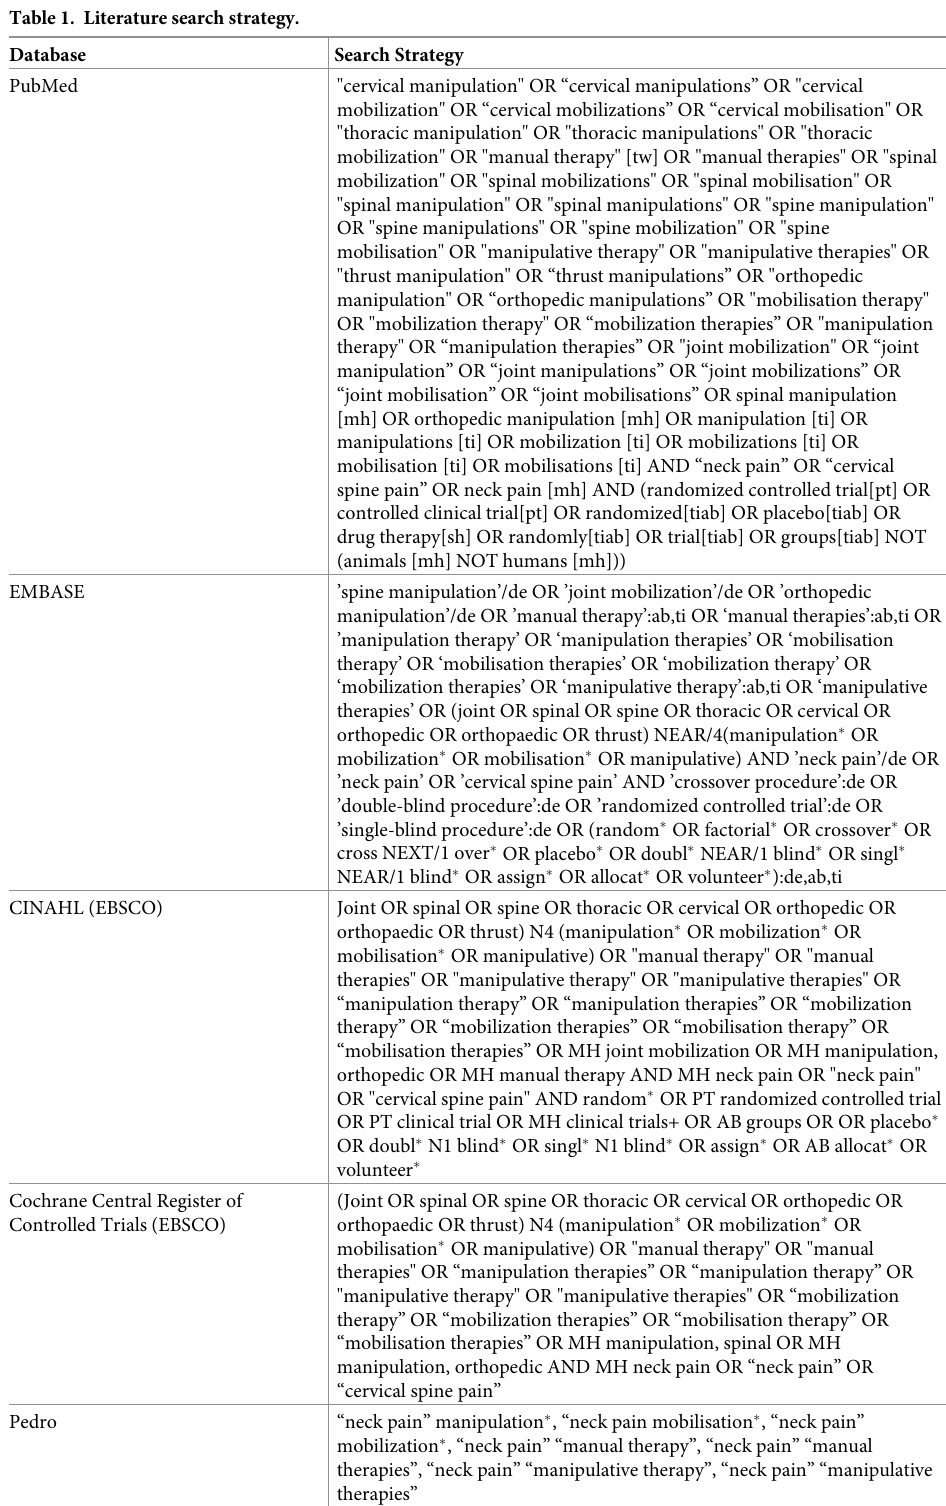
Table 1. Literature search